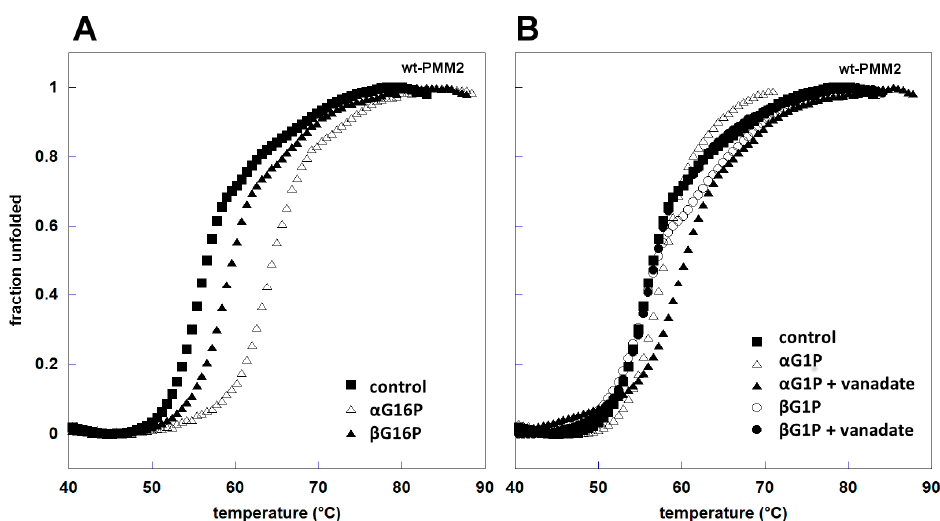
Figure 6. Thermal stability in the presence of ligands. wt-PMM2 0.3 mg/mL was incubated with different ligands 0.5 mM (( A ) α G16P and β G16P; ( B ) α G1P and β G1P, with and without vanadate); the melting curves were measured in the presence of dithiothreitol (DTT) 1 mM and Sypro Orange 2.4x, from 20 to 90 °C with increments of 1 °C/min.